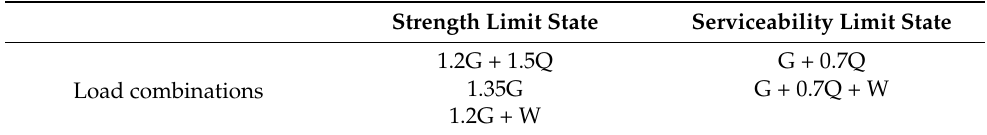
Table 3. The linear load combinations.